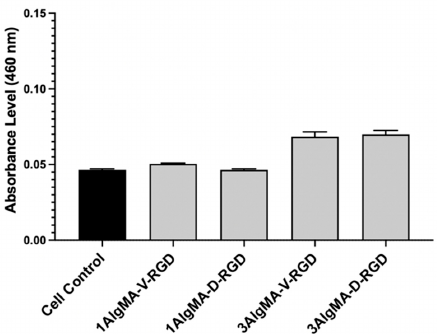
Figure 5. Using a quantitative WST-8 mitochondrial activity assay after 24 h of culture, the scaffold materials were non-toxic to C2C12 cells in vitro.